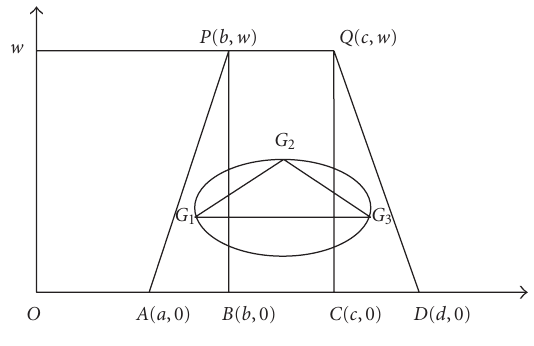
Figure 1: Circumcenterr of